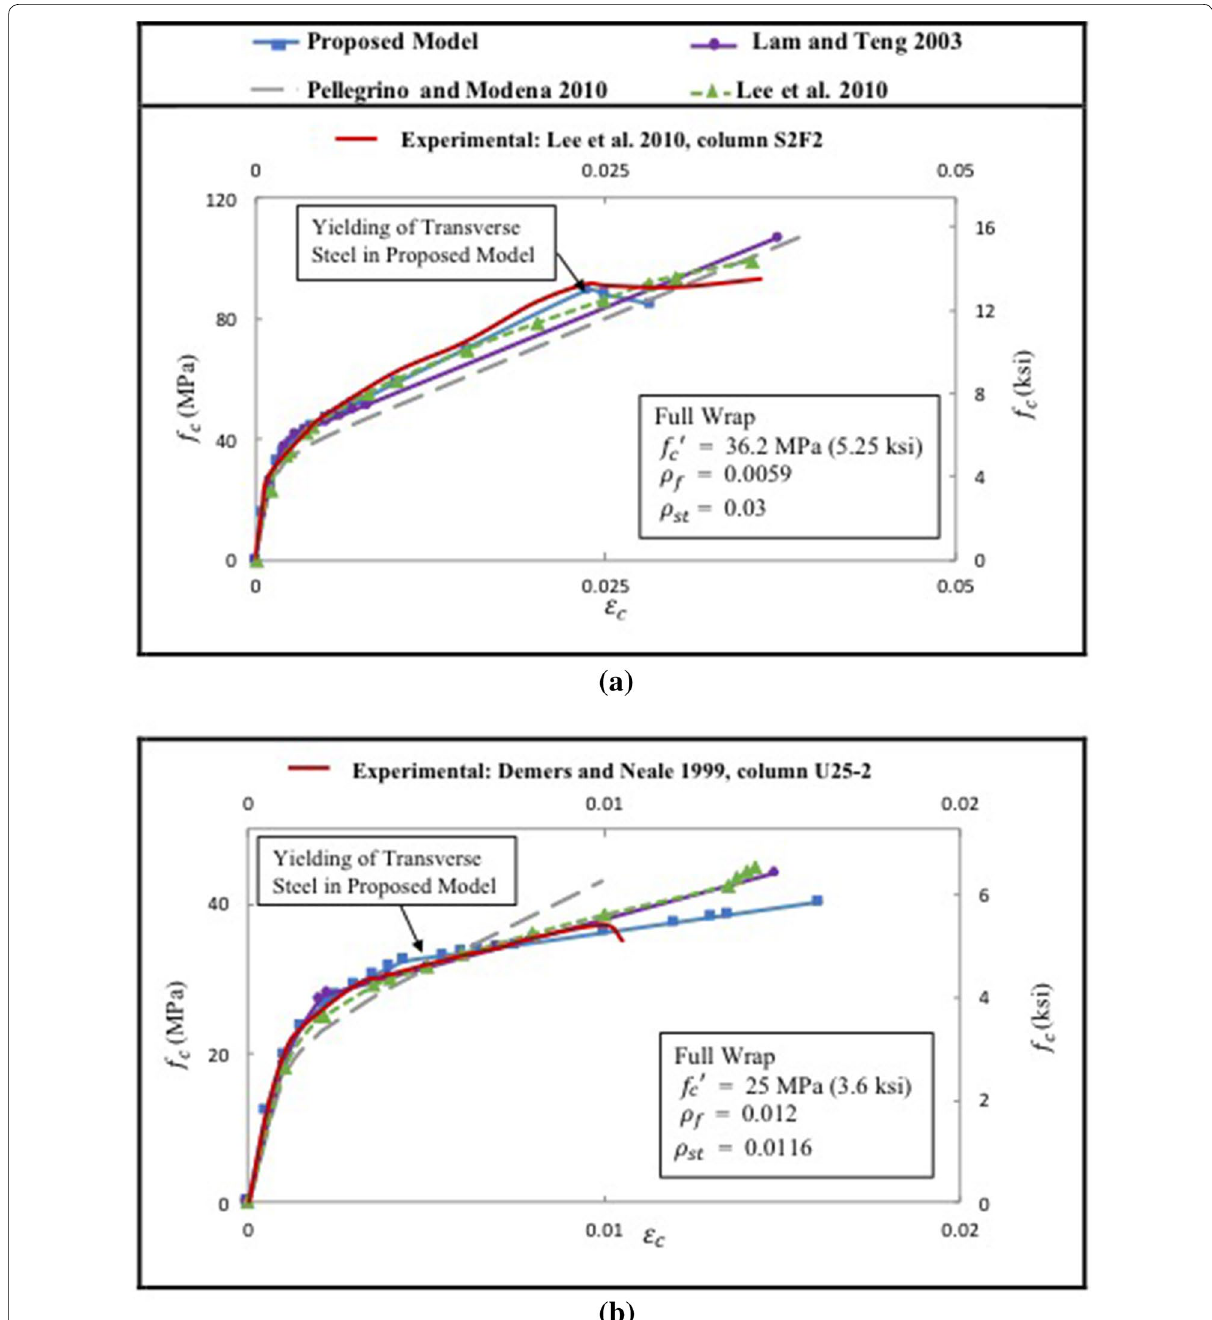
Fig. 11 Comparison between the proposed model and experimental compressive stress ( f c ) versus axial strain (ε c ) for fully wrapped circular RC